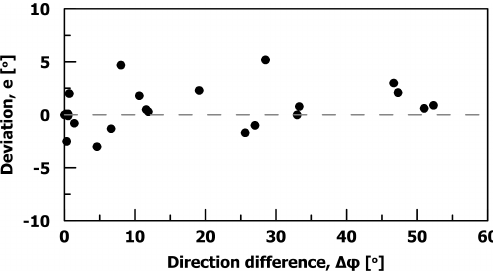
Figure 16. Deviation as a function of direction